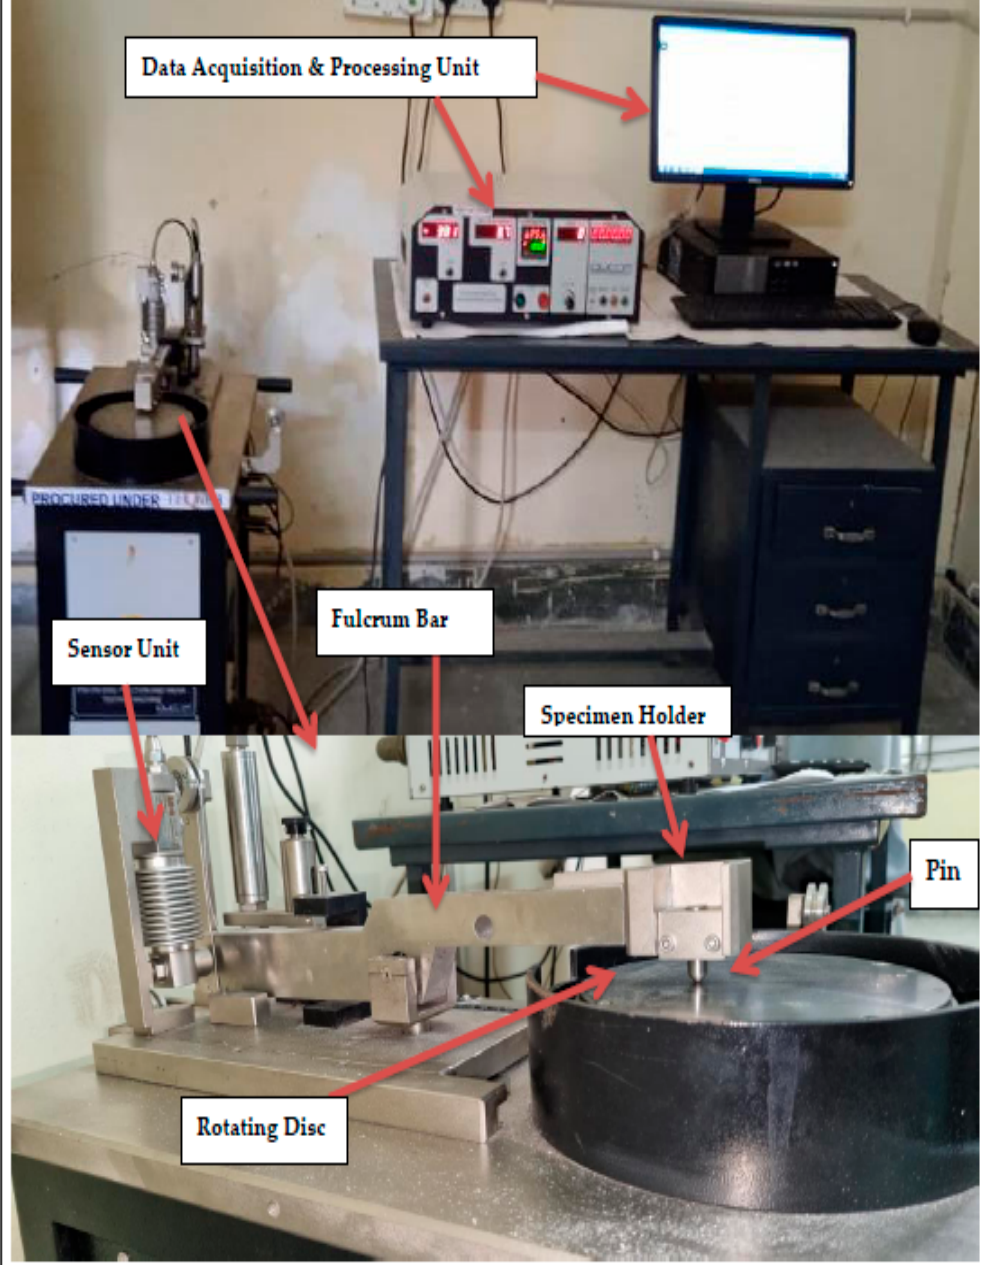
Figure 2. Schematic diagrams of experimental setup and enlarged view of pin-on-disc contact for wear analysis.